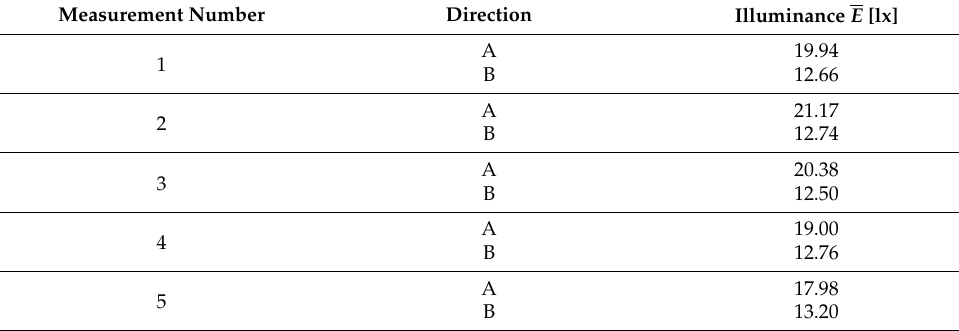
Table A9. Example of the results for measurement field No.